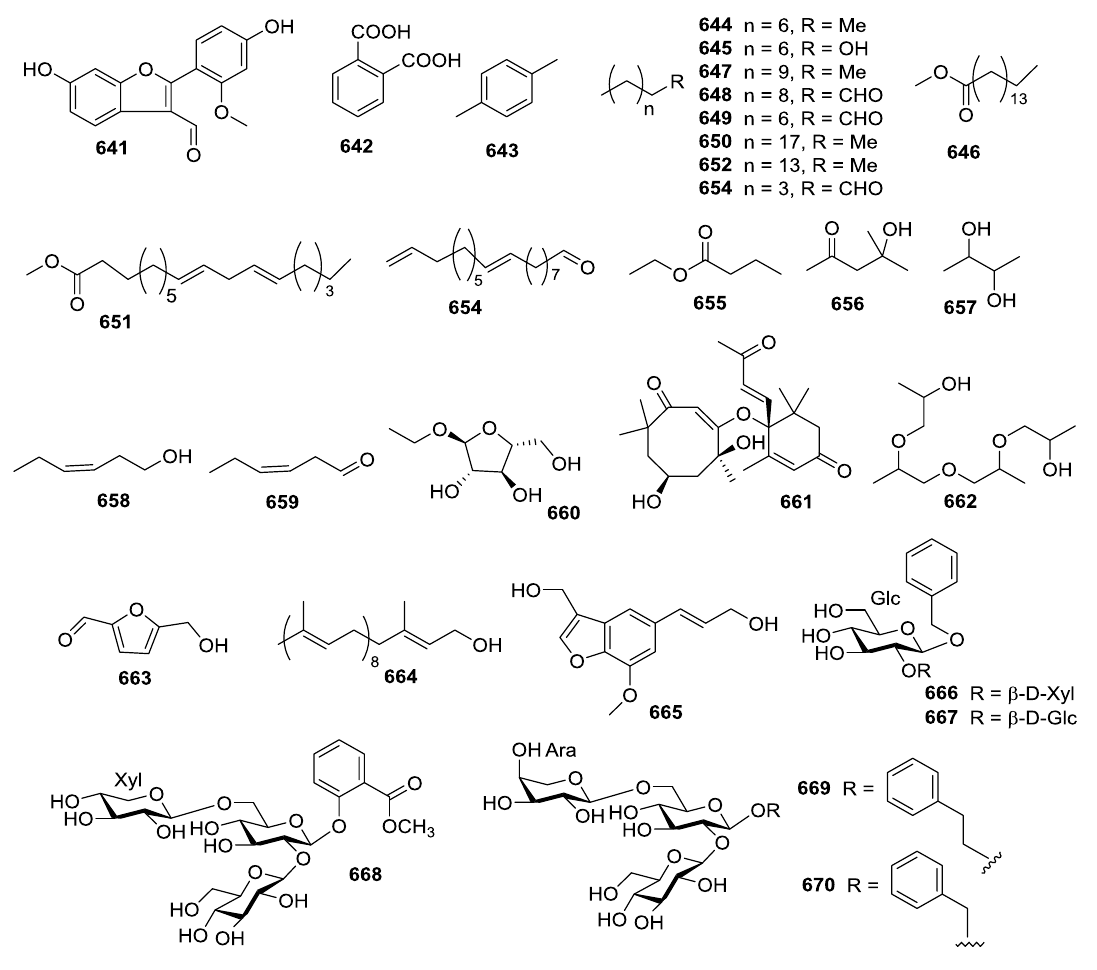
Fig. 16 Other compounds 641 – 670 from